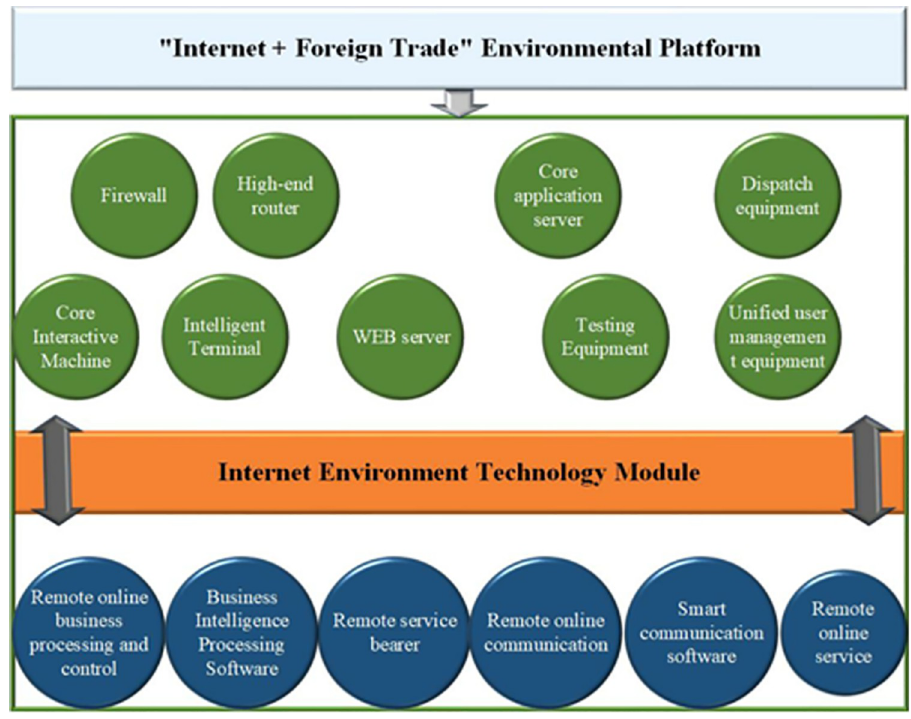
Fig 3. Technology environment module of controllable relevance big data mining model of foreign trade goods sales under the background of "Internet plus foreign trade".